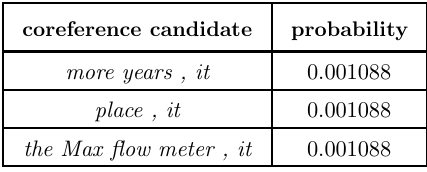
Table 2. Probabilities for coreference candidates for pleonastic